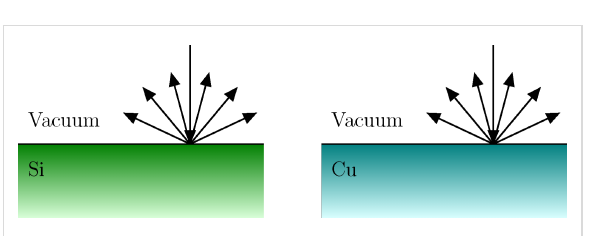
Recently, coincidence measurements of correlated electron pairs emitted from solids (Al, Si, Ag) under electron bombardment have been measured, providing a double-differential SE yield, differential with respect to the energy loss of the primary elec- tron and with respect to the energy (or the time of flight) of the emitted secondary electron [55]. These experimental data are displayed for Si under 100 eV electron bombardment in the lower panel of Figure 4 as a bird’s-eye-view plot (only the shape and relative intensities of the spectrum are of relevance here, hence the missing units in the linear color scale, where black is the null point and white is the maximum attained value). The horizontal white lines indicate the corresponding times of flight for electrons with 0 eV (accelerating grids were used), 50 eV, and 100 eV. See [55] for the experimental details. The plot can be read as the (time-of-flight) spectrum of second- ary electrons emitted as a result of different energy losses of the impinging electron (to be read at the abscissae). The upper panel of Figure 4 displays the REELS of 100 eV from Si, where the energy-loss peaks corresponding to the excitation of one surface plasmon, one bulk plasmon, and two surface plasmons are indicated by vertical red dashed lines and labeled, respect- ively, 1s, 1b, 2s as a guideline for the abscissae scale in the other plots of the figure.